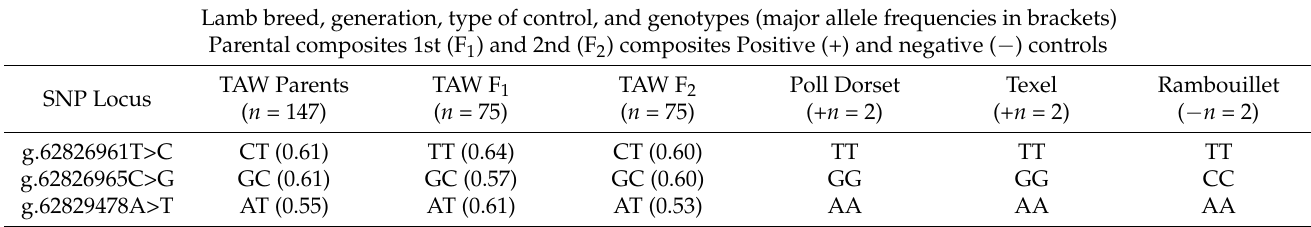
Table 4. FABP4 gene SNP (major allele frequency) in TAW 1 , Poll Dorset (+control) and Rambouillet ( − control) lambs. Lamb breed, generation, type of control, and genotypes (major allele frequencies in brackets) Parental composites 1st (F 1 ) and 2nd (F 2 ) composites Positive (+) and negative ( − ) controls SNP